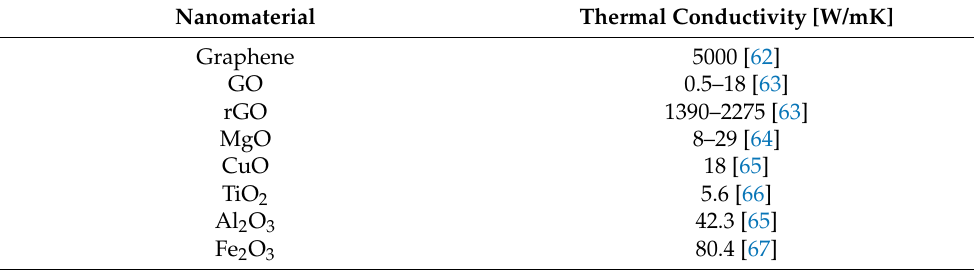
Table 2. Thermal conductivity of the most commonly used nanoparticles to prepare nanofluids.